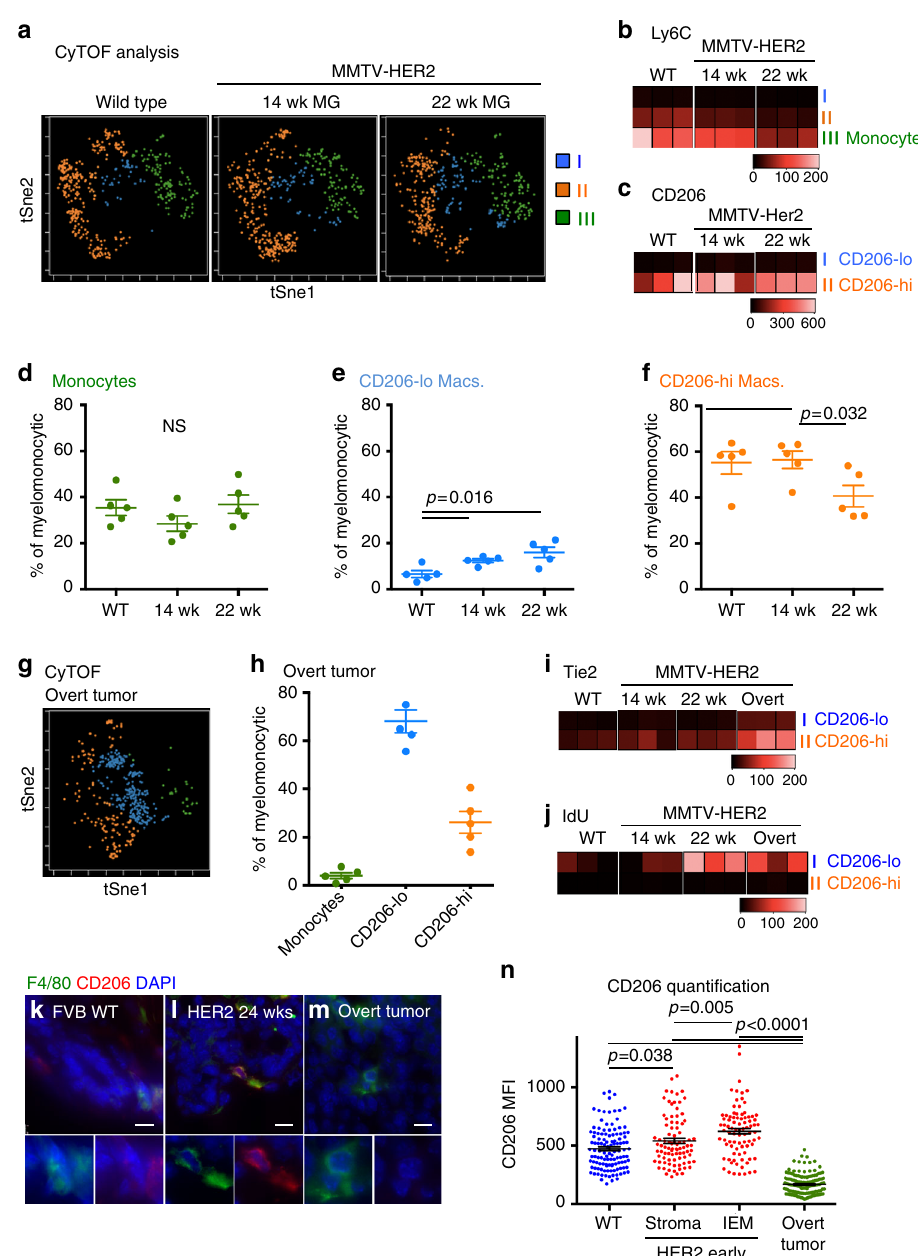
Fig. 5 Phenotypic pro fi ling of immune cells in early mammary cancer lesions. a Whole mammary glands from FVB wild-type mice or 14-week-old and 22- week-old pre-malignant MMTV-HER2 mice were analyzed by mass cytometry. viSNE plots were generated from myelomonocytic cells (gating strategy see Supplementary Fig. 4A, B). Results from one representative animal is shown; number of animals per group N = 5; individual experiments N = 2. The three sub-populations were identi fi ed as Ly6C + monocytes and CD206 hi and CD206 lo macrophages based on their expression levels of Ly6C ( b ) and CD206 ( c ). These three populations were then analyzed for their frequency amongst all myelomonocytic cells. d – f Dot plots show mean ± SEM of fi ve animals per group. Heat plots for three individual animals per group with expression levels of selected markers Ly6C ( b ), CD206 ( c ), Tie2 ( i ), and IdU incorporation as a proliferation marker ( j ) were generated for CD206 lo and CD206 hi macrophages as identi fi ed in the viSNE plots. g , h viSNE plot and quanti fi cation of myelomonocytic population in overt MMTV-HER2 tumors ( fi ve mice per group). Mammary glands from FVB wild-type mice ( k , 22wks), MMTV-HER2 mice at 24wks ( l ) and overt MMTV-HER2 tumors ( m , 26 – 30wks) were stained against CD206 and F4/80 and CD206 signal intensity in F4/80 + macrophages was quanti fi ed; zoom factor in k , l , and m , 2x. Plot n depicts mean ± SEM, each dot represents one macrophage; three animals combined. All bars: 10 μ m. All statistical testing was done with 95% con fi dence interval by Mann – Whitney